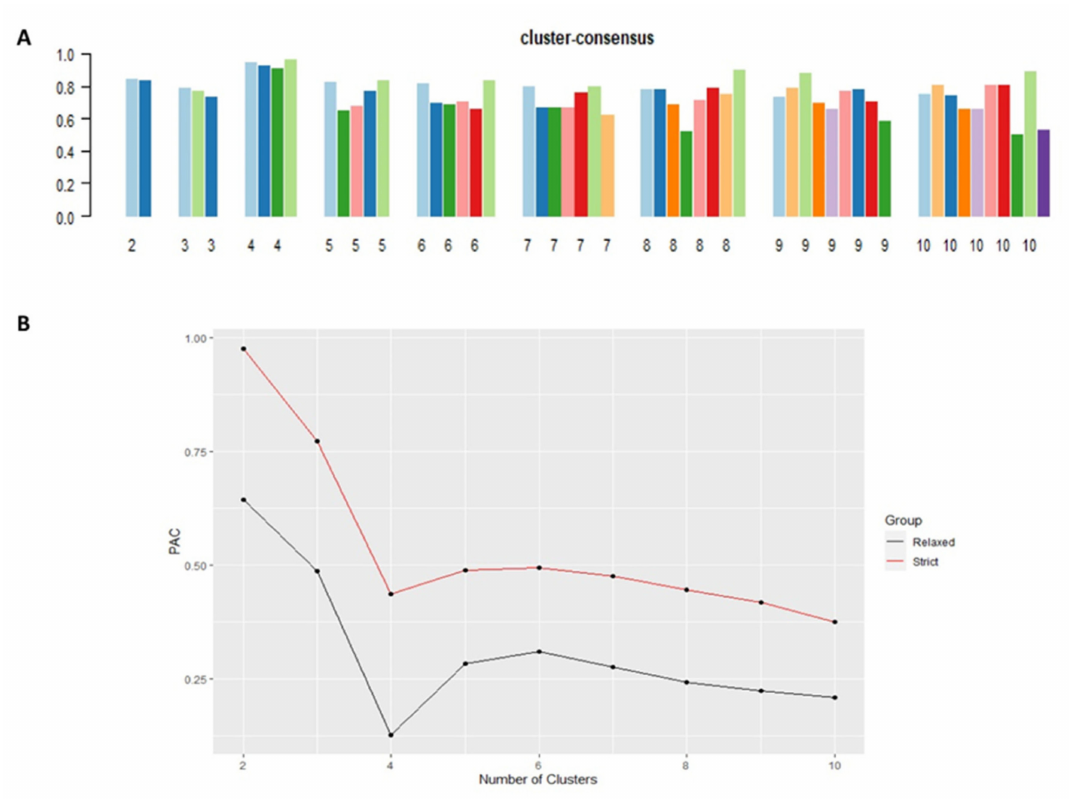
Figure 2. ( A ) The bar plot represents the mean consensus score for different numbers of clusters (K ranges from two to ten); ( B ) Definition for ambiguously clustered pairs utilizing PAC values with the strict criteria (red line) with the predetermined boundary of (0, 1), and the PAC values with the relaxed criteria (black line) with the predetermined boundary of (0.1, 0.9). Hospital mortality was 1.7% for cluster #1, 4.4% for cluster #2, 3.9% for cluster #3, and